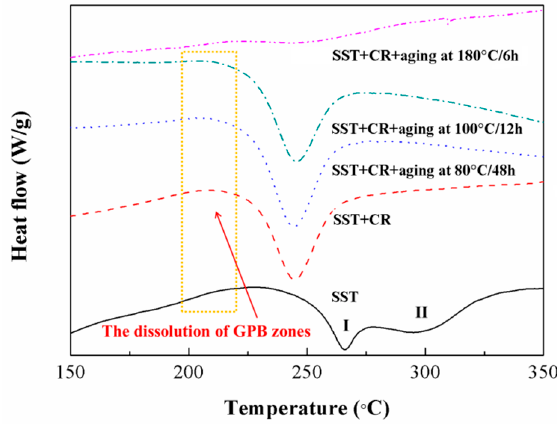
Figure 5. Di ff erential scanning calorimetry (DSC) curves of TiB 2 / 2024 composite in di ff erent Figure 5. Differential scanning calorimetry (DSC) curves of TiB 2 /2024 composite in different states. Conclusively, after post-cold rolling aging treatment at 100 °C for 12 h, a good combination of strength and ductility can be achieved. In comparison with other post-cold rolling alloys, a pre- stretched aging in situ TiB 2 /2024 composite and ex situ 2024 composites (Figure 3e), the post-cold rolling TiB 2 /2024 composite has exhibited better combined mechanical properties.